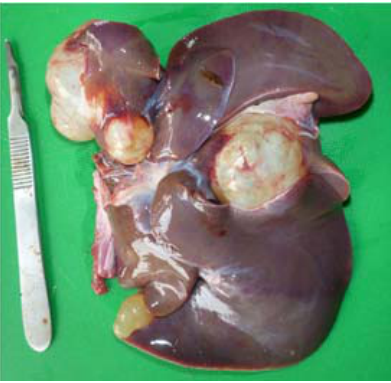
Figure 1. Liver with hydatid cysts. Photo: A. Shima.